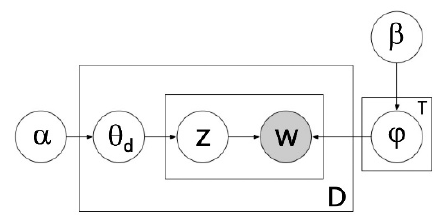
Figure 1. Bayesian network of latent Dirichlet allocation (LDA) [47].